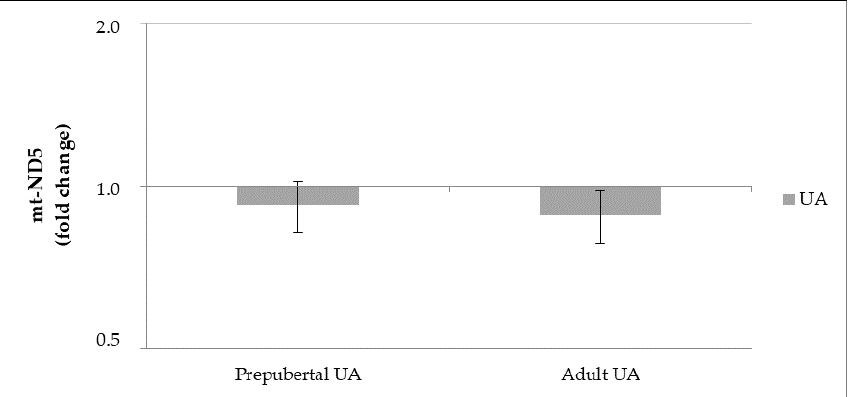
Figure 5. mt-ND5 copy number in granulosa cells (GCs) from prepubertal and adult cows (prepu- bertal: control, Urolithin A (UA); adult: control, UA, n = 5 for each group) supplemented with UA in the medium culture, assessed by qPCR using DNA. Results are normalized to their respective GCs control samples. mt-DNA copy numbers in control GCs for ND5 gene were set to 1. Data are expressed as the ratio of CT values mean ± standard error mean (SEM).